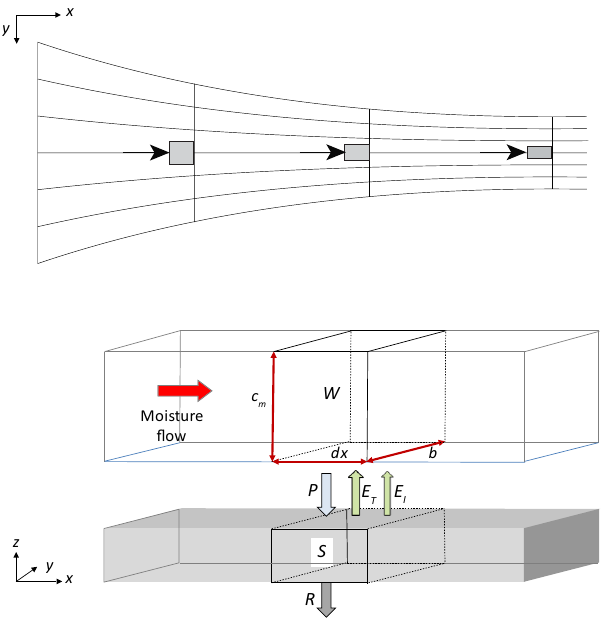
Fig. 1. Sketch of the model (top view and a side view); note that lateral transport through advection is only modelled for the atmo- spheric control volume, not for the